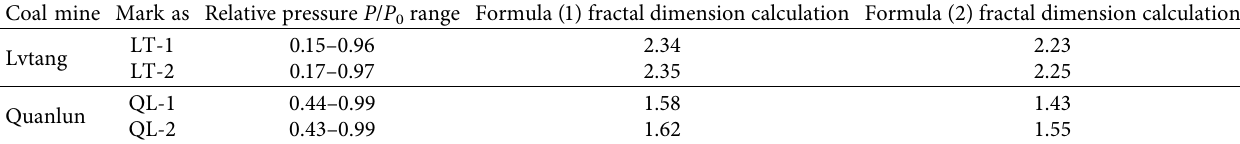
Table 3: Calculation results of the surface fractal dimensions of coal samples.